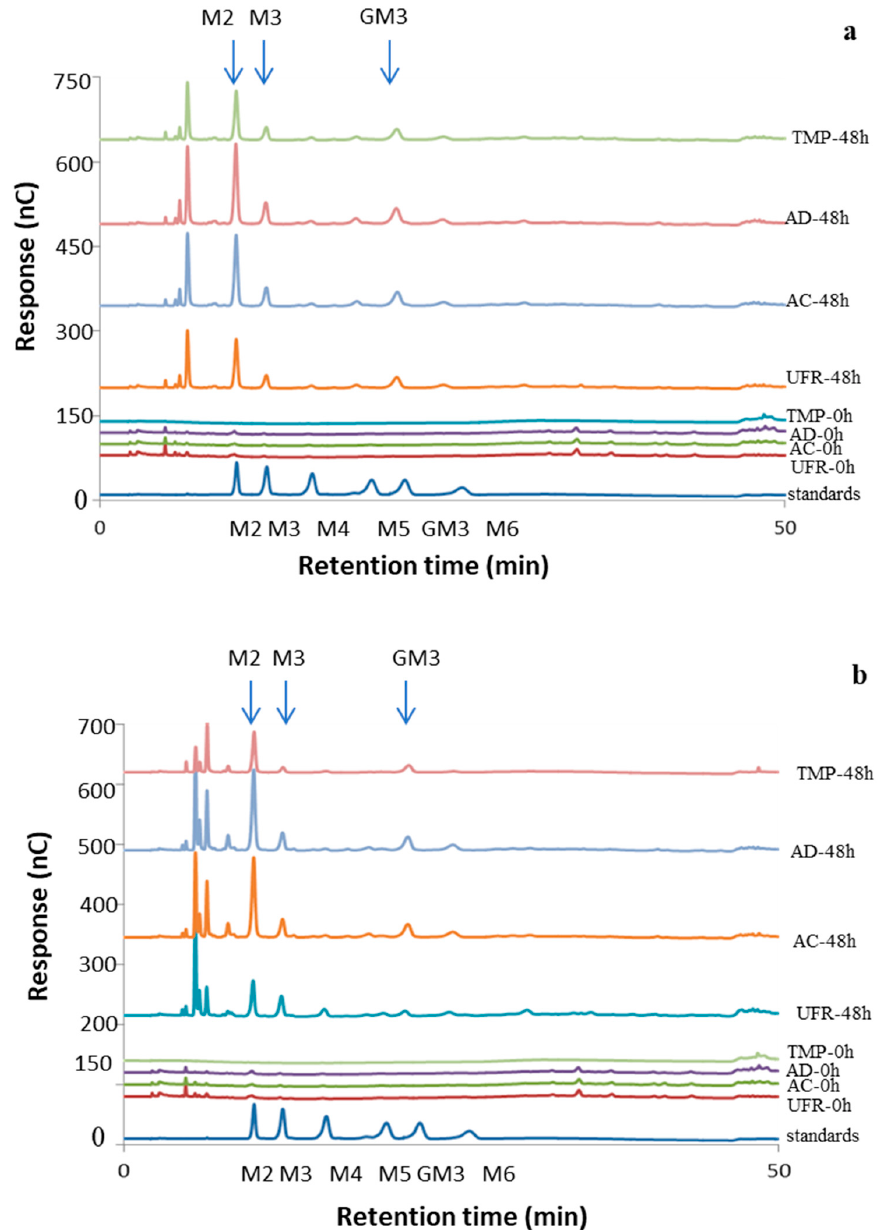
Figure 3. Product profile after hydrolysis of SSL-AcGGM preparations and TMP-AcGGM using ( a ) Tr Man5A ( b ) Viscozyme L. Aligned HPAEC-PAD chromatograms depicting the oligosaccharide product profile obtained after hydrolysis of UFR, AC, AD SSL-AcGGM preparations and TMP-AcGGM used at an initial concentration of 100 mg/mL of GGM after hydrolysis by Tr Man5A and Viscozyme L, used at a protein loading of 0.1 mg/mL. The enzymatic hydrolysis was carried out over 48 h of incubation at 40 ◦ C and pH 5.0. The arrowheads indicate the major products that were determined in the hydrolysate based on their retention time with known standards.